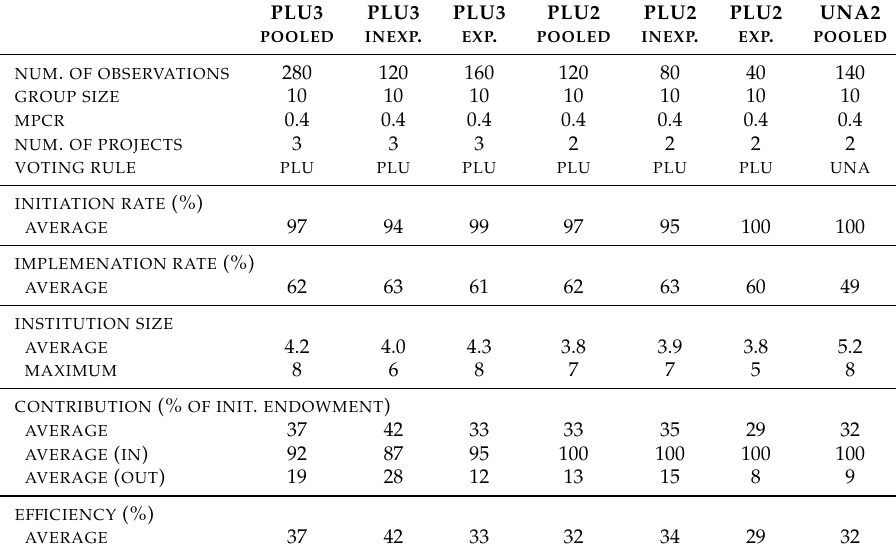
Table 3. Summary of experimental results (part